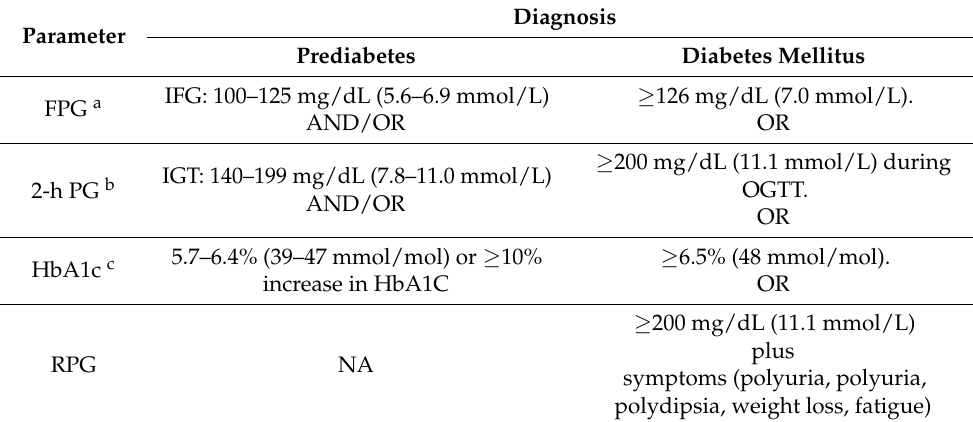
Table 3. The diagnostic criteria of